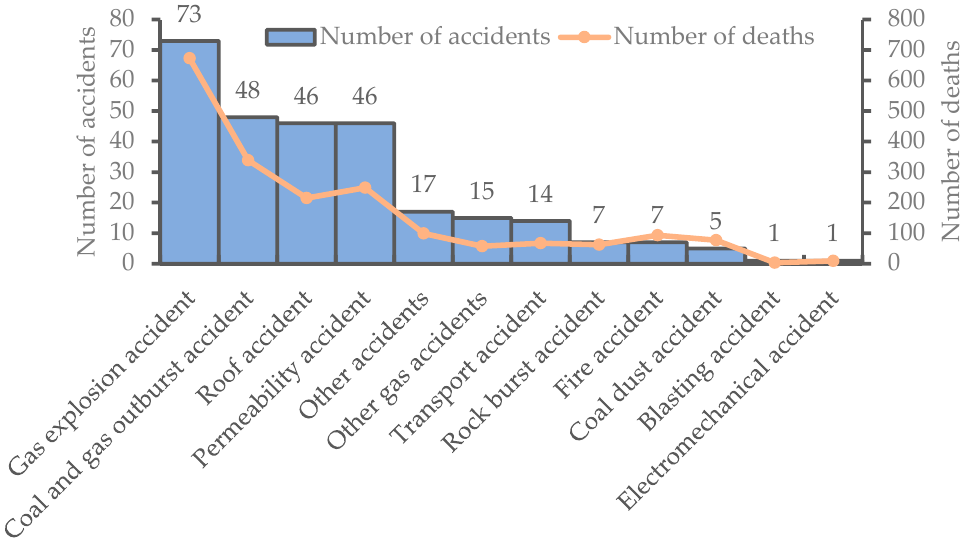
Figure 1. Distribution of coal mine accident frequency and deaths in China from 2013 to 2020. In the era of big data, it is an indisputable objective fact that computationalism (using the perspective of computing to examine, analyze, and solve security problems) and da- daism (using data to speak) is widely applied within various fields and different disci- plines [12]. The complexity of security and system problems promotes the transformation of related research from low dimensional to high dimensional, from linear to nonlinear, from small to large, and from scalar to vector. Artificial intelligence, data mining, and machine learning are frequently used [13]. Previous models for coal mine gas explosion accident statistics do not meet the demand of the current analysis, such as the correlation between the cause of the accident and the exploration and classification of hazard control.